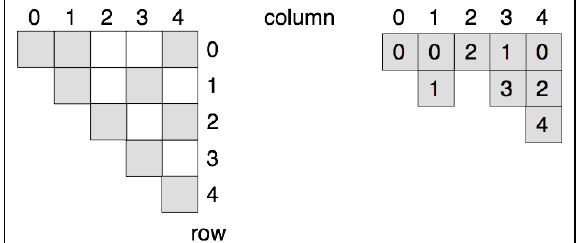
Figure 2: Five-image network illustrating the relationship between an upper triangular matrix in dense storage (left) and the same matrix in Block Compressed Column Storage ( BCCS ) (right). Zero-blocks (in white on the left) are not stored in BCCS format. Numbers inside blocks on the right are row